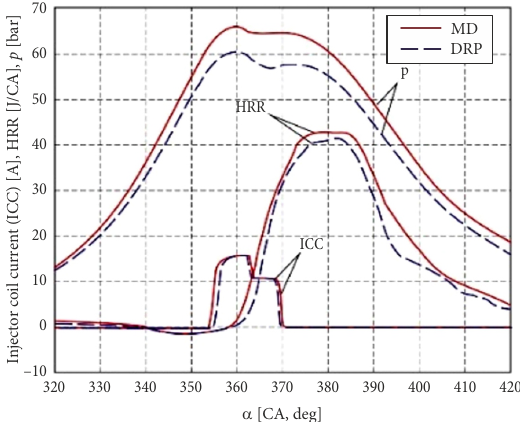
Figure 7. Injection current vs CA for MD and DRP